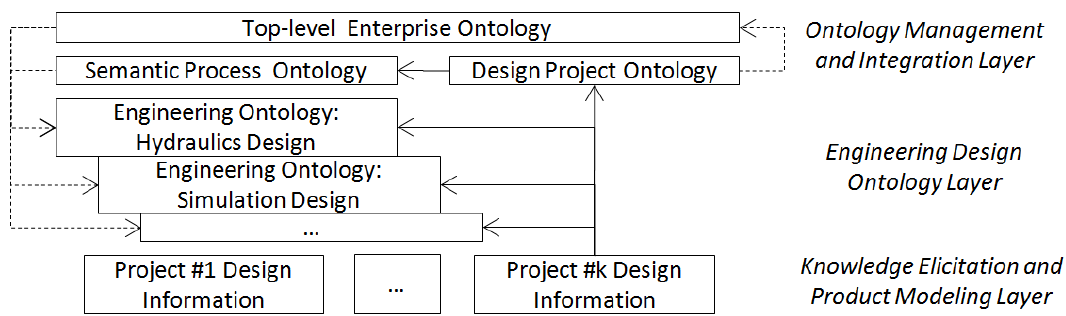
Figure 4. A simplified information architecture for machine